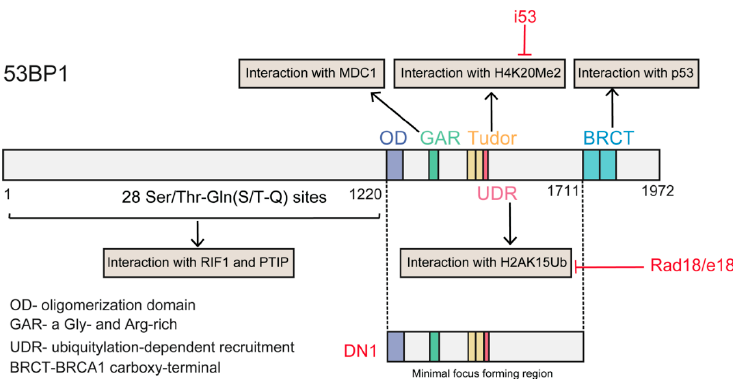
Figure 5. Structural domains of the 53BP1 protein and its interaction partners. The red color text indicated the different approaches of inhibiting 53BP1 function. The i53 targets in Tudor domain and interferes the interaction of 53BP1 with H4K20Me; Rad18/e18 interferes the interaction of 53BP1 with H2AK15Ub; DN1 a dominant negative version of minimal focus forming region .